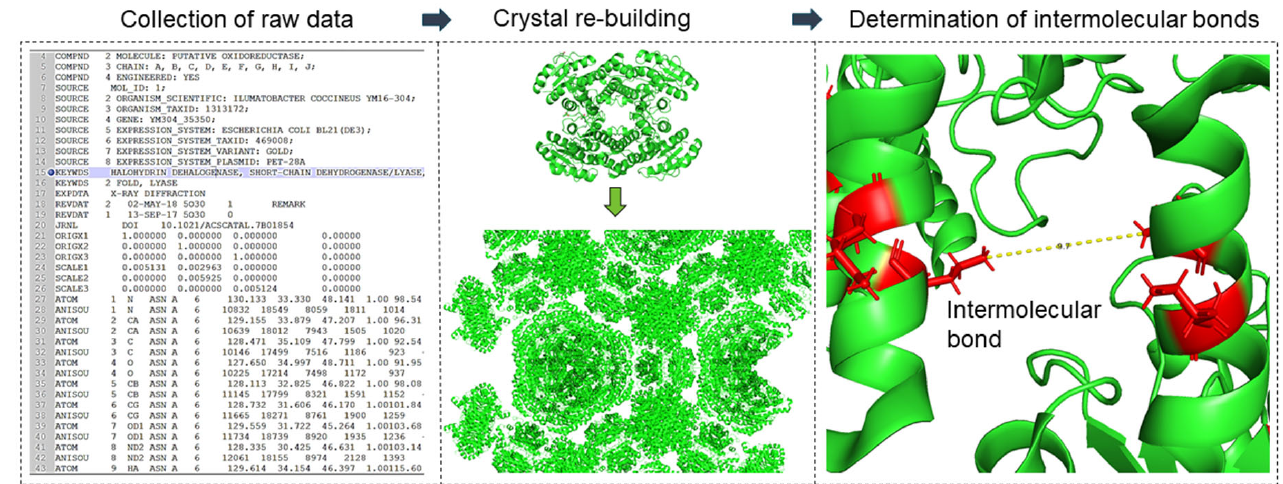
Figure 2. Overview approach to modeling mechanical crystal behavior based on crystal structure: investigation and classification of inter ‐ and intramolecular cross ‐ linking bonds.